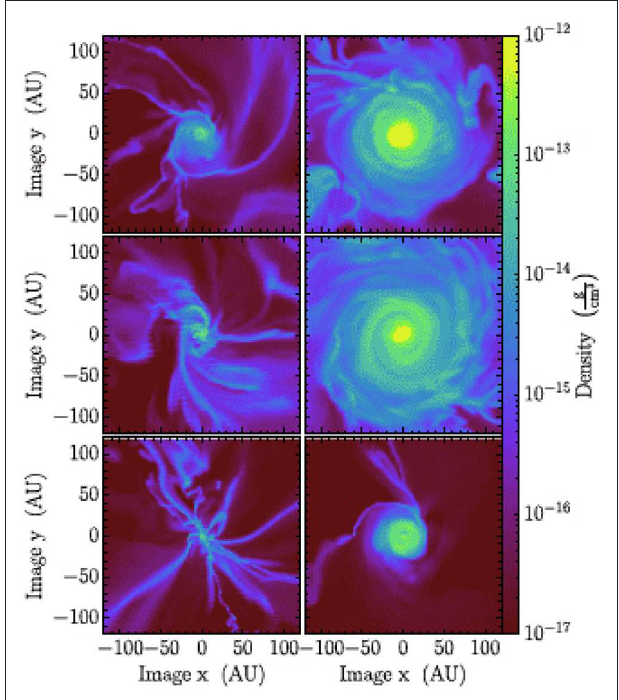
FIGURE 7 | Slices in the plane vertical to the mean angular momentum vector calculated for a sphere of 100 au at t = 50 kyr. First row: sink 1 (left), sink 4 (right); second row: sink 5 (left), sink 6 (right); third row: sink 7 (left), sink 9 (right). From Kuffmeier et al. (2017) reproduced with permission c